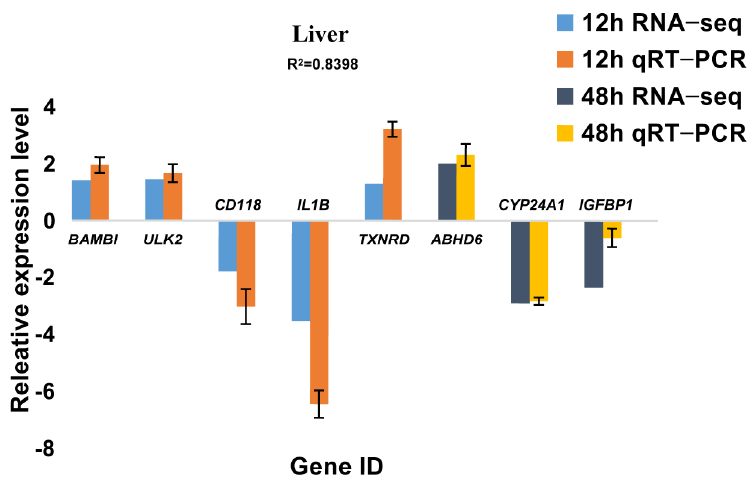
Figure 10. Results of qRT − PCR for Some Di ff erentially Expressed Genes in the Liver.